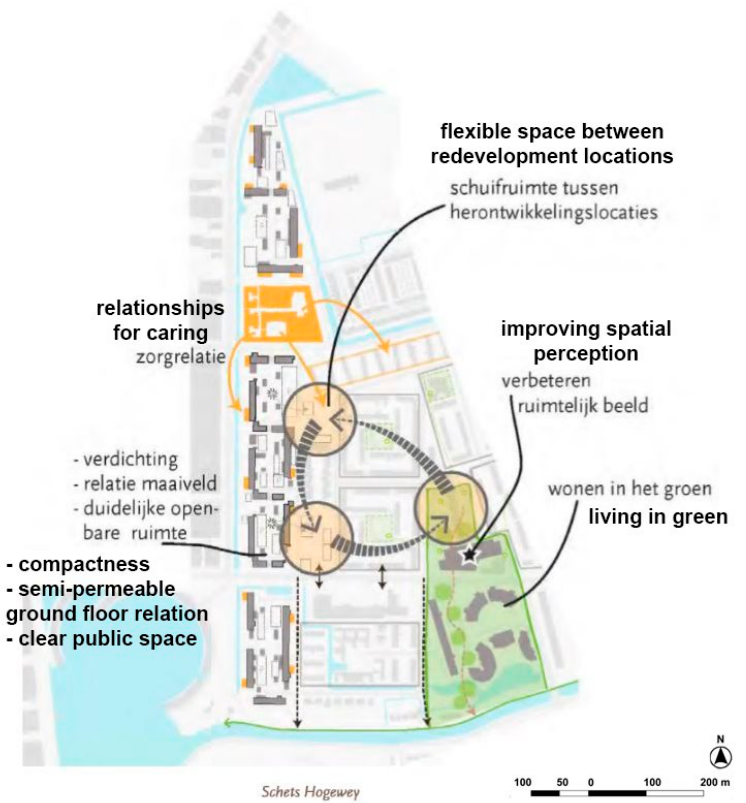
Figure 22. The municipal strategic plan proposes De Hogeweyk as a relevant stakeholder to strengthen relations for care in the immediate surrounding (Weesp Municipality, 2014, p. 92).